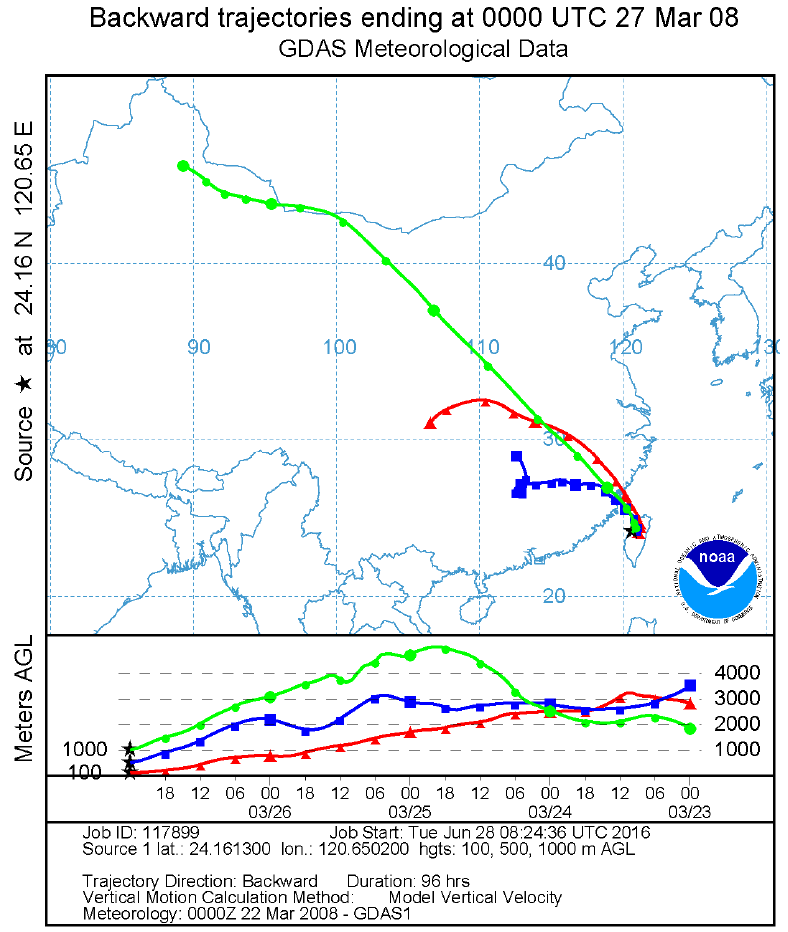
Figure 8. The 96-h backward trajectories of the air parcels in Taichung at 0000 UTC March 2008. The red, blue, and green curves represent the air parcels at the surface, 100 m, and 1000 m, respectively.